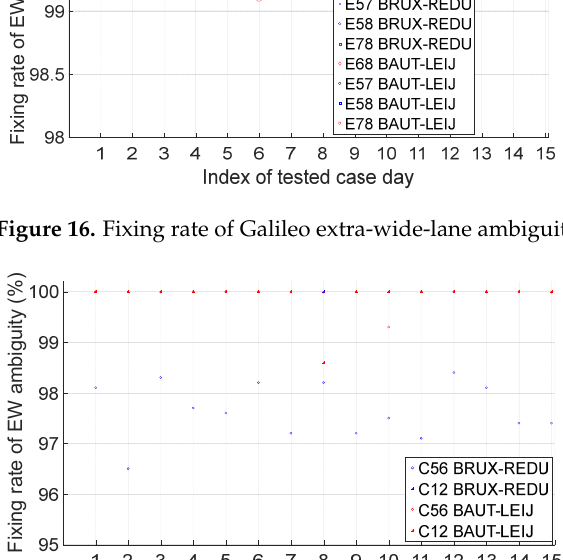
Figure 17. Fixing rate of BeiDou extra ‐ wide ‐ lane ambiguity.